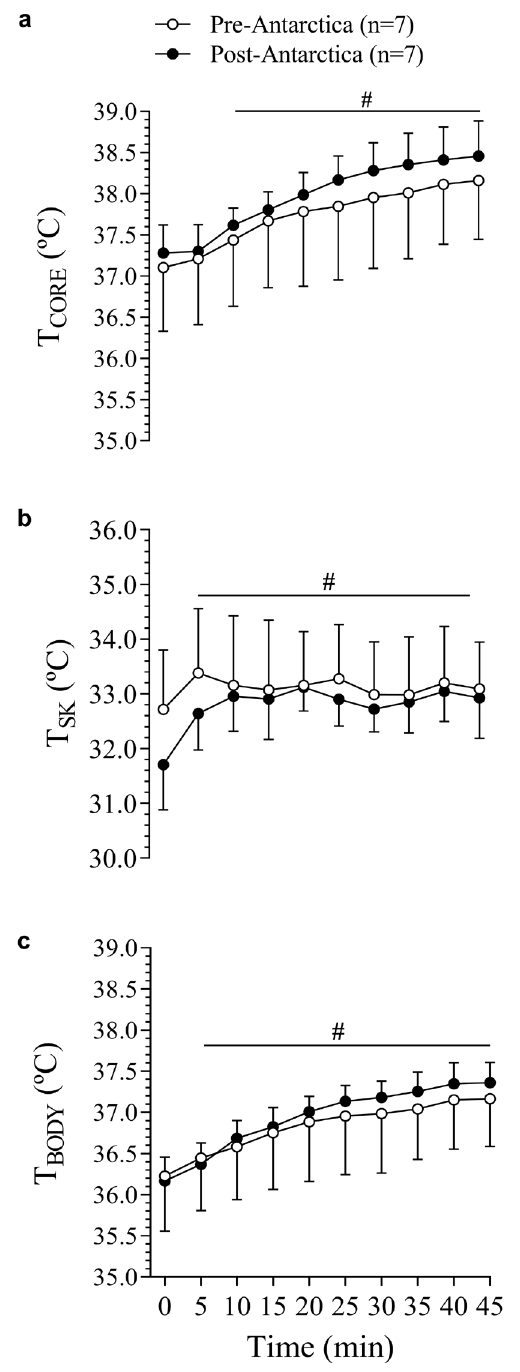
Figure 2. Body temperatures during the exercise heat stress performed before and after the Antarctic expedition (n = 7). The following variables were measured: a) core body temperature (T ); b) mean CORE body temperature (T ); c) mean skin temperature BODY (T ). # Significantly different (P < 0.05) from 0 min. The SK data are expressed as means ±